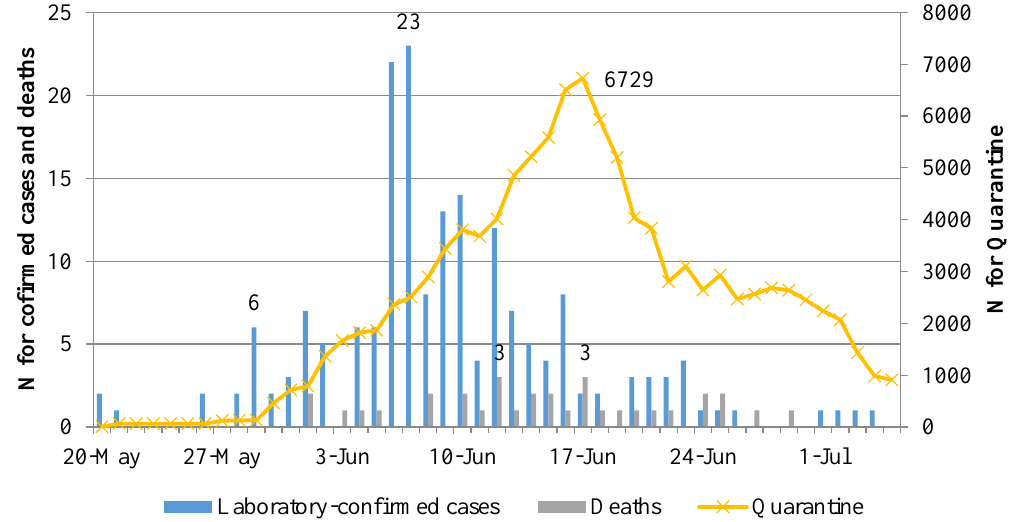
Figure 1. Daily statistics for laboratory-confirmed Middle East respiratory syndrome coronavirus (MERS-CoV) cases, deaths, and quarantine.